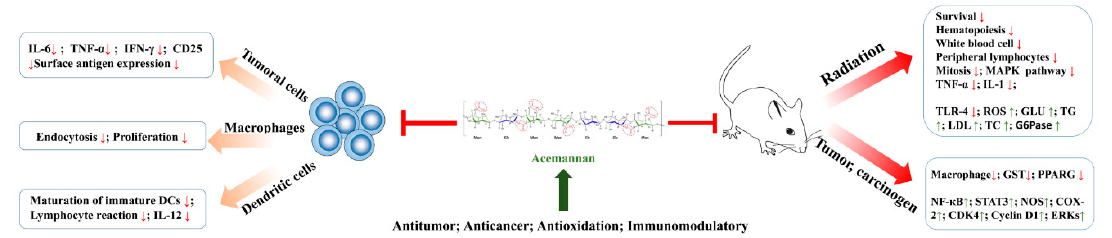
Figure 2. Pharmacological e ff ects of acemannan in vitro and in vivo.